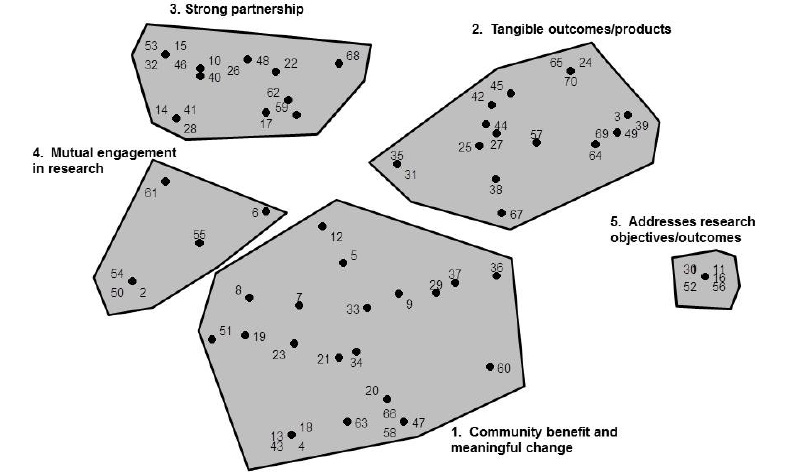
Figure 3: Characteristics